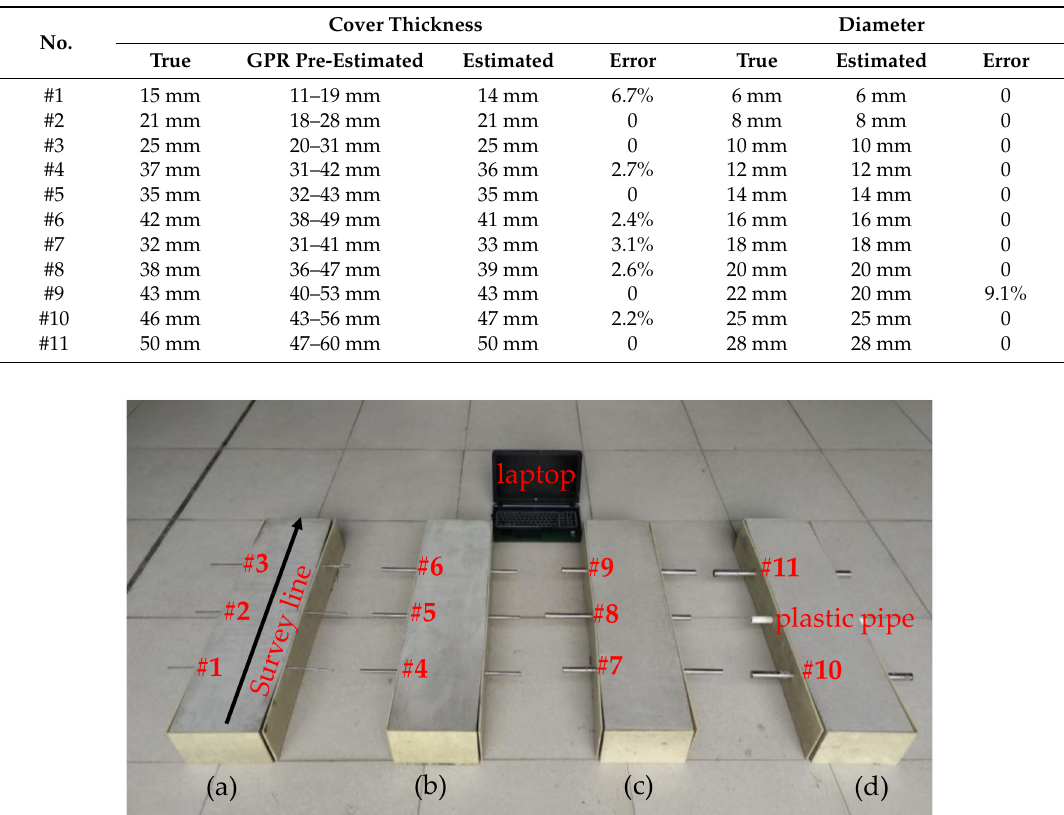
Table 1. True and estimated rebar diameters and cover thicknesses in the laboratory experiment, and their relative errors.